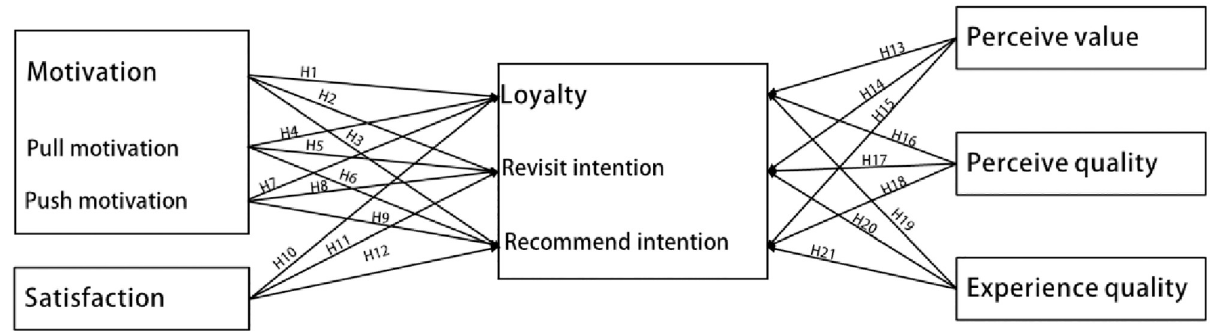
Fig 1. Five-factor tourist loyalty theoretical